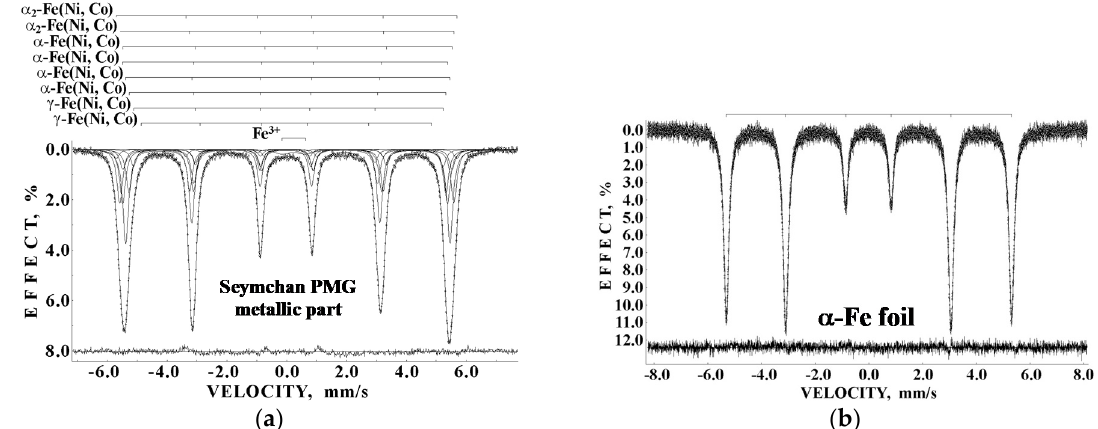
Figure 19. Room temperature Mössbauer spectra of Seymchan PMG metallic part measured in 4096 channels and presented in 1024 channels ( a ) and reference α -Fe foil measured in 4096 channels ( b ). Indicated components are the results of the best fits. The differential spectra are shown on the bottom. Adapted from [45].